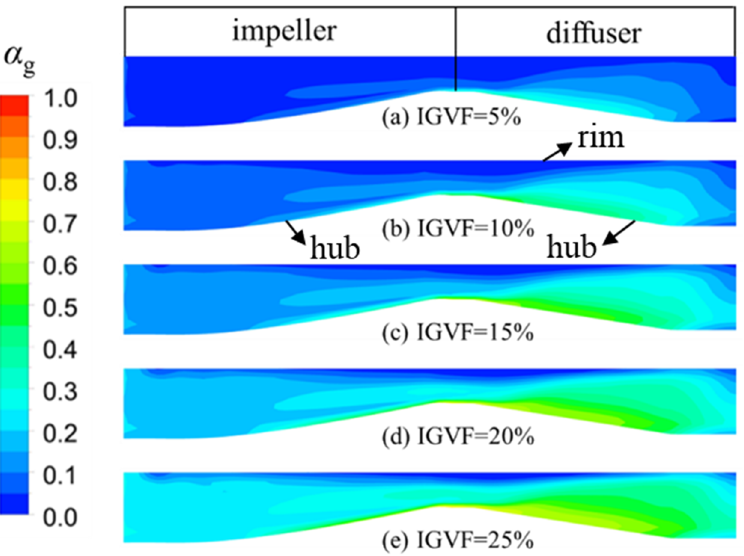
Figure 6. Distributions of gas void fractions in the impeller and diffuser under different